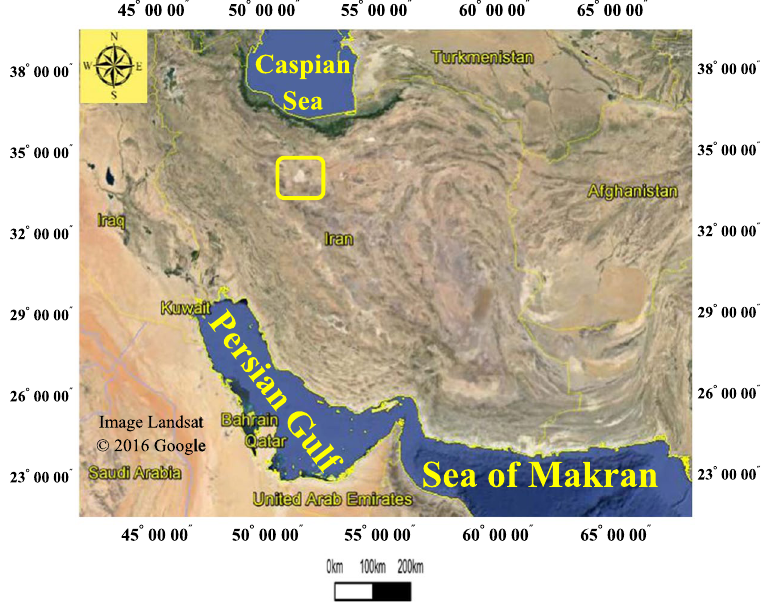
Figure 1. The location of the Rigboland sand sea shown by yellow rectangle in centre of Iran (Image from Google Earth Software).